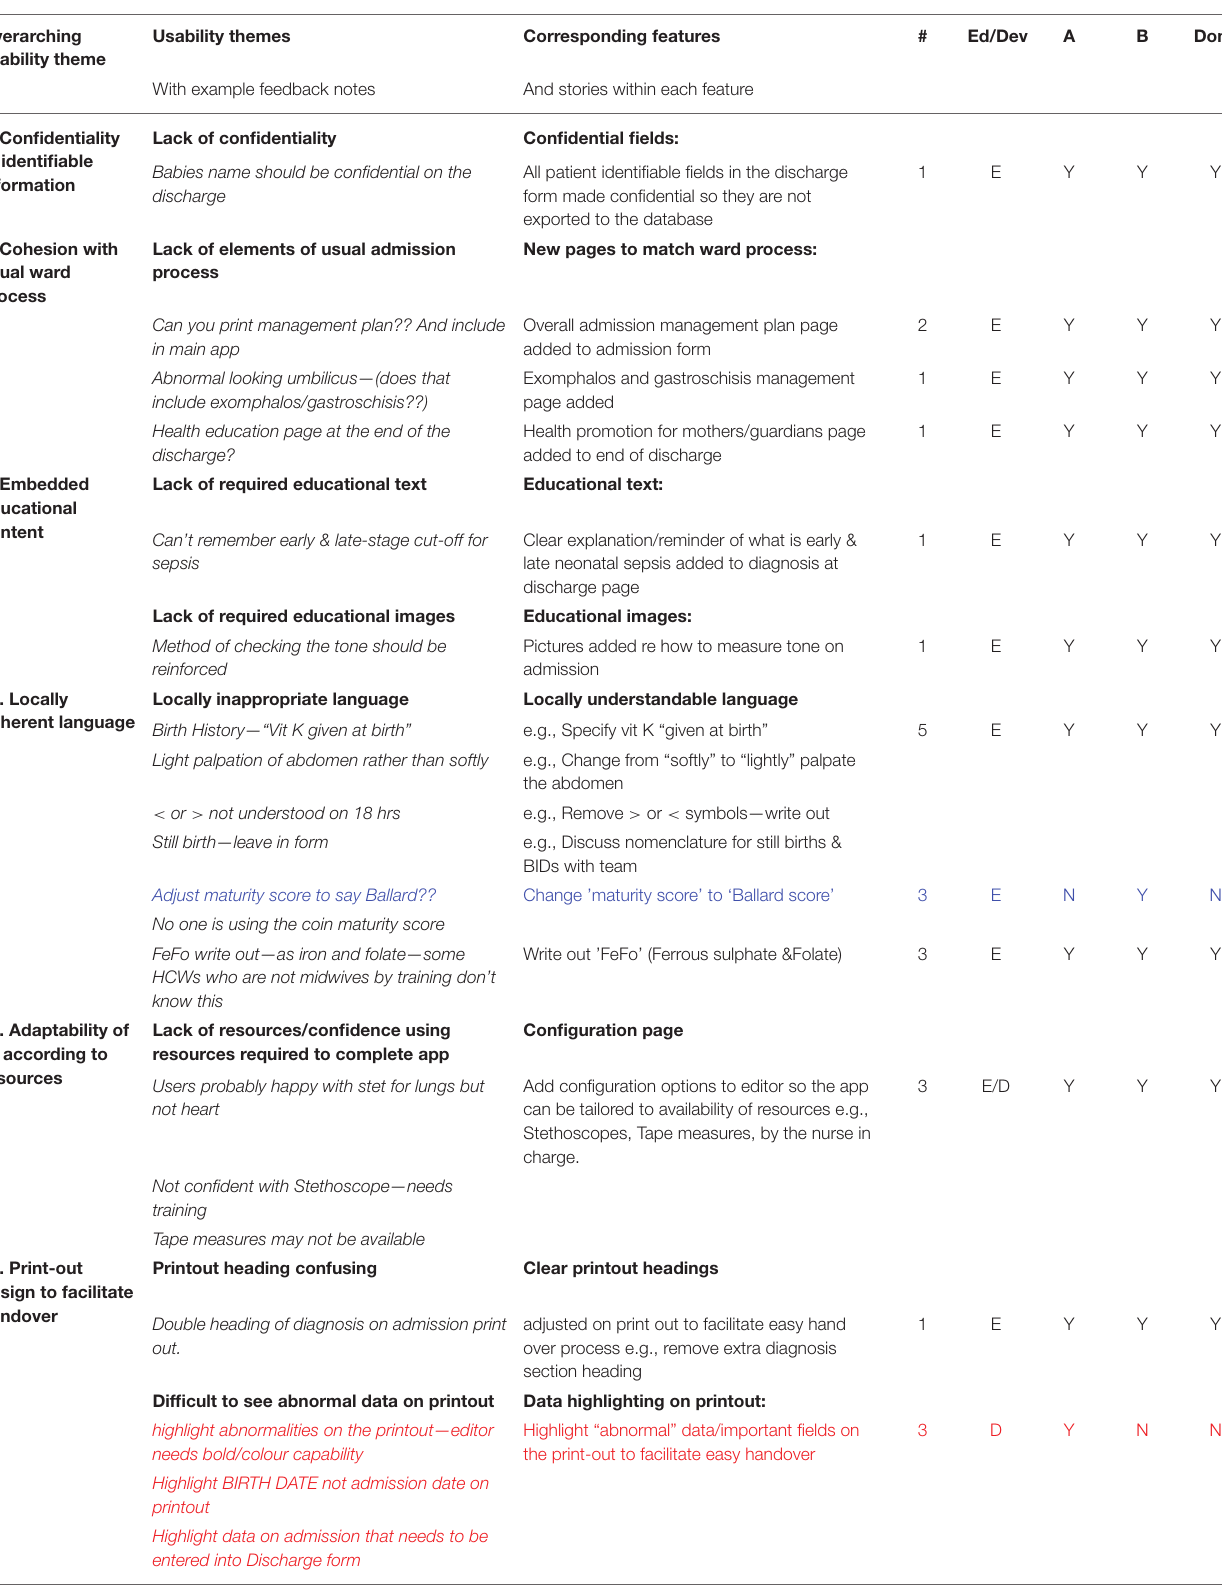
TABLE 5 | Usability relating to clinical care—clinical care feature set. Overarching usability